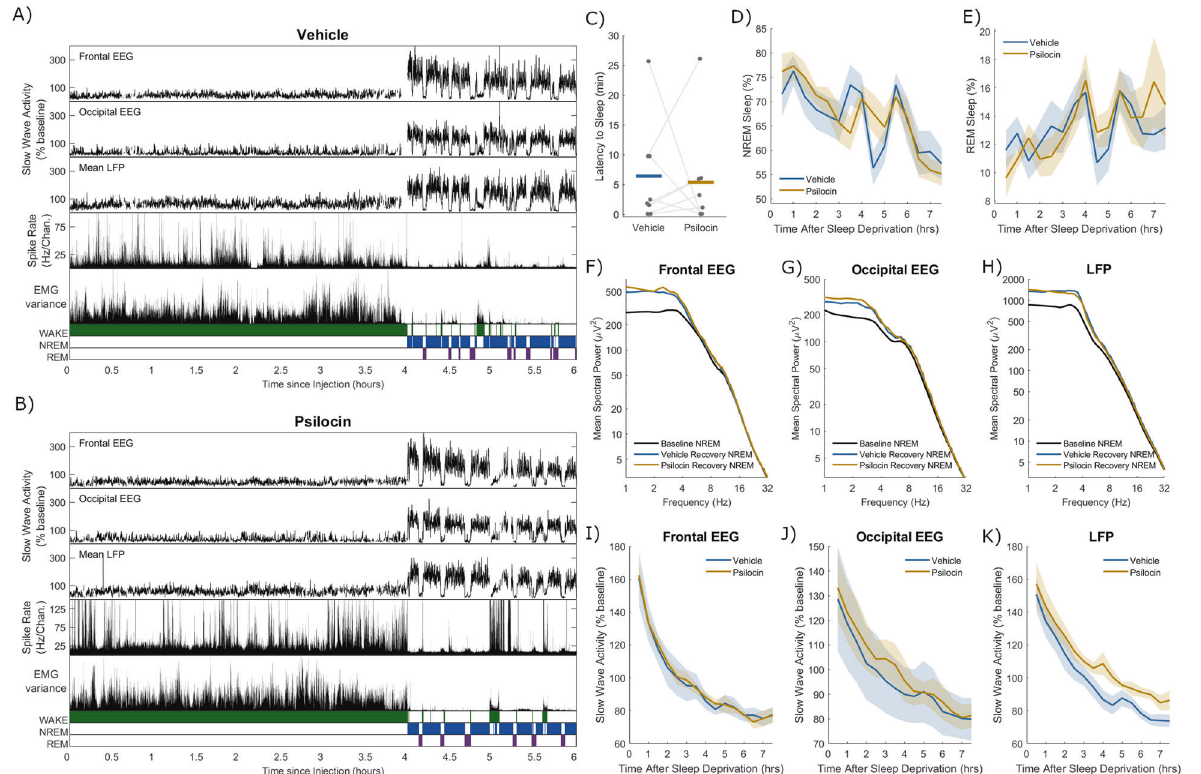
Fig. 4 Recovery sleep after sleep deprivation paired with vehicle and psilocin injection. A representative example of slow-wave activity (0.5 – 4 Hz power) derived from frontal electroencephalogram (EEG), occipital EEG, and mean local fi eld potential (LFP), alongside the total recorded spike fi ring rate (spikes per second per channel), the variance of the electromyogram (EMG) and scored vigilance states, all with a resolution of 4 s over a period of 6 h comprising 4 h of sleep deprivation and 2 h of recovery sleep, including A ) injection with vehicle, and B ) injection with psilocin. C ) Latency from the end of sleep deprivation to the fi rst episode of NREM sleep at least 1-minute duration. Grey dots correspond to individual animals, with grey lines linking values from the same animal, coloured lines indicate the group mean for vehicle (blue) and psilocin (yellow) conditions. The percentage of time scored as D ) NREM sleep and E ) REM sleep from the end of sleep deprivation until the end of the light period. Coloured lines denote the mean and ranges the standard error of the mean. The mean power spectra of F ) frontal EEG, G ) occipital EEG and H ) mean LFP in NREM sleep in the fi rst period of sleep after the end of sleep deprivation, compared with mean spectra over all NREM sleep the baseline day. The time series of slow-wave activity (0.5 – 4 Hz power, relative to that on the baseline day) derived from I ) frontal EEG, J ) occipital EEG and K ) mean LFP, from the end of sleep deprivation until the end of the light period. Individual time points correspond to averages of slow-wave activity in overlapping 1-hour windows centred every 30 signi fi cantly lower exponential time constants in the psilocin condition (vehicle: mean = 0.11 h − 1 , psilocin: mean = 0.09 h − 1 , p = 0.028, paired t -test). To explore whether this effect is present in the prefrontal cortex, this analysis was repeated including only animals with con fi rmed electrode placements in prefrontal (prelimbic and infralimbic) cortex, fi nding the same signi fi cant effect of psilocin and a decreased decay rate of SWA during recovery sleep after sleep deprivation (Drug: F (1,90) = 16.7, p < 0.001; Time: F = 17.6, p < 0.001; Interaction: F = (14,90) (14,90) 0.14, p = 0.99; two-way ANOVA). This result implies that Process S recovered more slowly during sleep after sleep deprivation combined with psilocin, but only on a local level, at least in prefrontal and adjacent cortex, and not at the global level as measured with EEG.